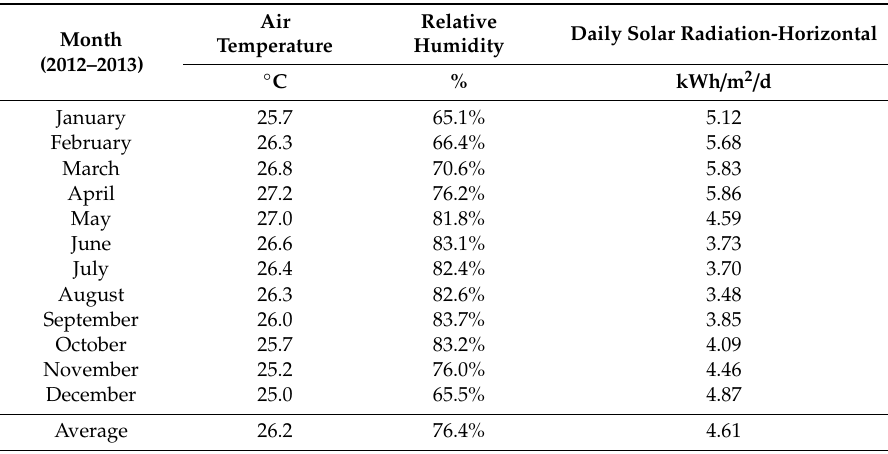
Table 2. Meteorological data at the case study area [11].